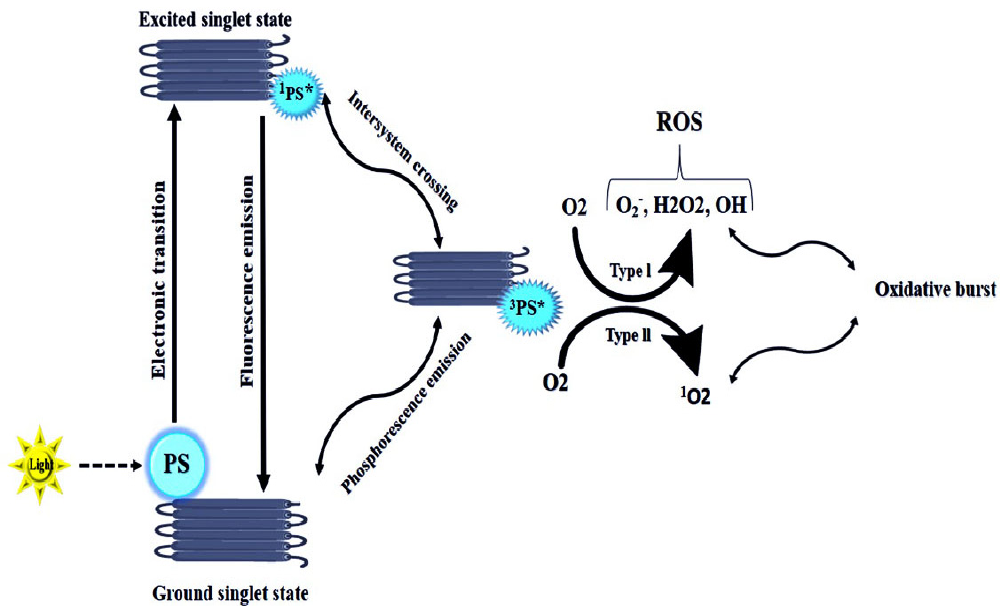
Figure 1. Mechanism of action of antimicrobial photodynamic therapy. The ground state (S0) photosensitizer absorbs a photon to form the first excited singlet state ( 1 PS) that can undergo intersystem crossing to form the first excited triplet state ( 3 PS). The long − lived triplet state can interact with molecular oxygen in two ways: type I electron transfer to form superoxide and the hydroxyl radical, or type II energy transfer to form 1 O2. The generated ROS can damage a broad spectrum of microorganisms.